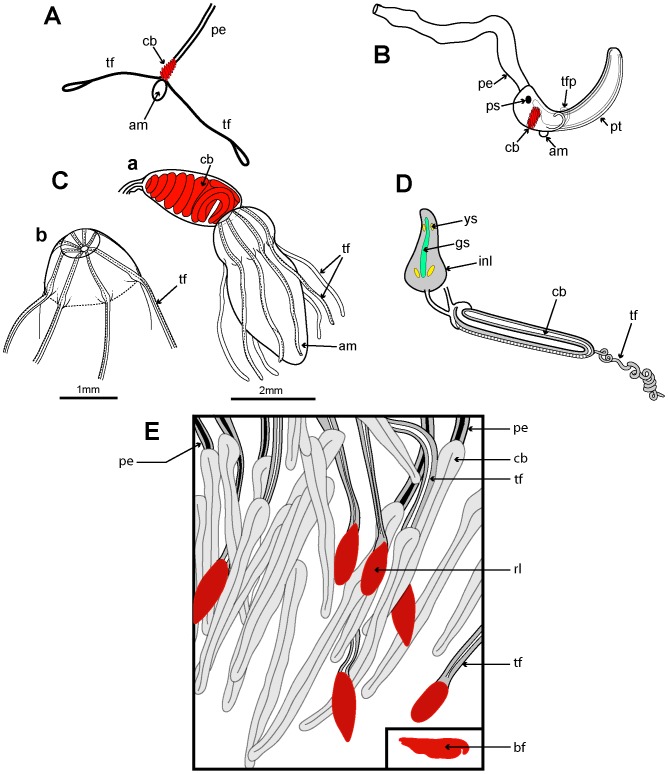
Lures in some physonect siphonophores.A: Agalma okeni copepod mimic lure (after fig. 2A [157]); B: Athorybia rosacea dendritic tentillum fish larva mimic lure (adapted from fig. 2B [157], fig. 46B [2] and pl. 1, fig. 8 [158]); C: a: Lychnagalma utricularia hydromedusa mimic lure (redrawn from fig. 5B [131], in part); b: proximal end of detached ampulla mimicking hydromedusa radial canals (redrawn from fig. 5A [131]); D: Resomia ornicephala fluorescent involucral lure (after figure in table 6
[91]); E: Red fluorescent lures on tentilla of Erenna sp. (redrawn from internet image by Steven Haddock 2004 © MBARI). Labels: am – ampulla; bf – red barbelet fish (the likely prey of this Erenna species); cb – cnidoband; gs – green stripe; inl – involucral lure; pe – pedicel; ps – pigment spot (mimics fish eye); pt – pendant growth (mimics fish body); rl – red lure (photophore); tf – terminal filament; tfp – terminal filament (mimics fish pectoral fin); ys – yellow spot(s).